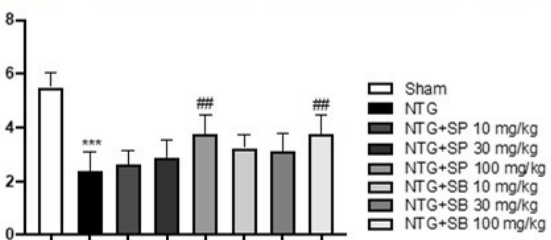
Figure 6. SCFAs treatment restores ZO-1 expression. Immunofluorescence staining revealed that NTG group was characterized by a decrease of ZO-1 expression ( B ) compared to sham group ( A ), however SCFAs treatment ( E , H ) significantly restored ZO-1 expression. No significant difference was observed in SP- and SB-treated-mice at the lower dose of 10 mg/kg ( C,D,F , G ). The yellow arrows indicated positive cells. ( I ) *** p < 0.001 vs. sham; ## p < 0.01 vs. NTG.